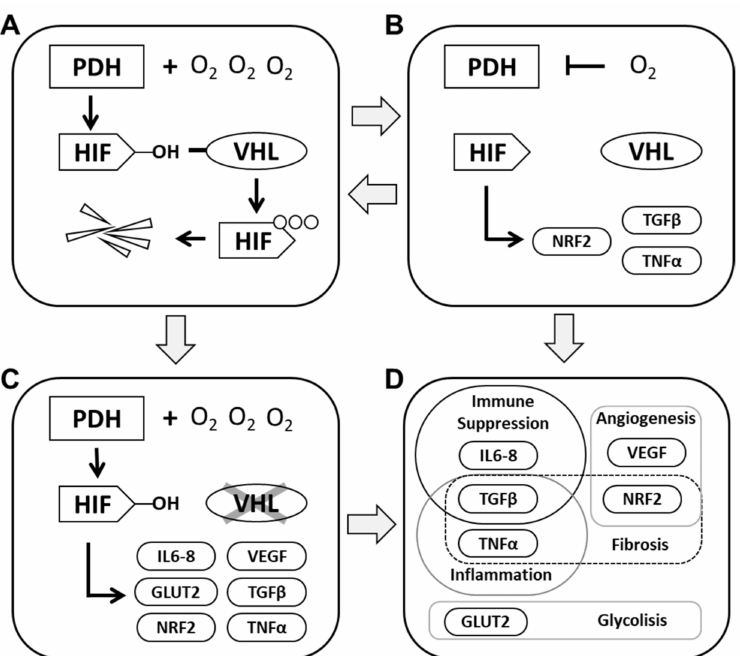
Figure 1. Cellular response to oxygen levels. ( A ): Under normal conditions, PHD have access to sufficient oxygen levels to promote the hydroxylation of HIF and maintain a stable expression of these transcription factors. Excess HIF is a target for proteolytic degradation mediated by VHL. ( B ): When cellular oxygen levels drop below the levels required to ensure PDH activity, HIF expression is destabilized. VHL is precluded from recognizing HIF and a lack of degradation leads to the activation of a myriad of genes with diverse functionalities. HIF activity will ensure cell survival and facilitate the restoration of physiological oxygen levels. Unchecked HIF activity can result in the sustained expression of inflammatory factors. ( C ): In RCC, the loss of VHL activity leads to the constitutive activation of HIF and a predominantly inflammatory and unbalanced cellular activity. ( D ): The differential activity of HIF in low oxygen conditions or in the absence of VHL leads to upregulation of several interconnected cellular